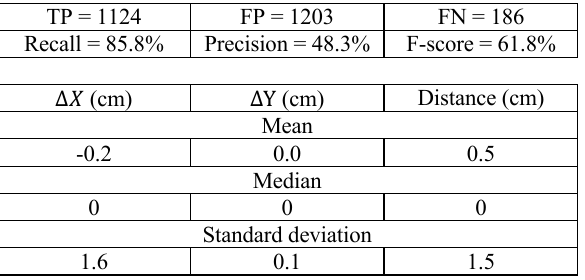
Table 2: Quantitative results for vertical object vectorization.